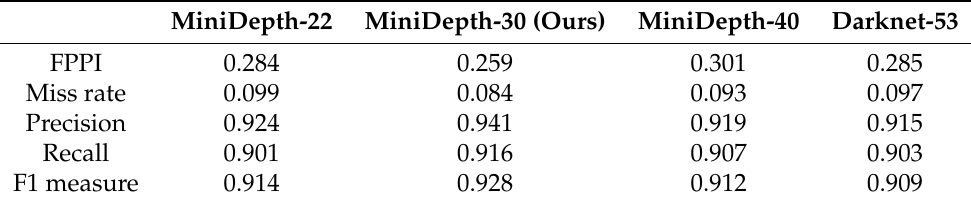
Table 4. Evaluations for network depth selection.